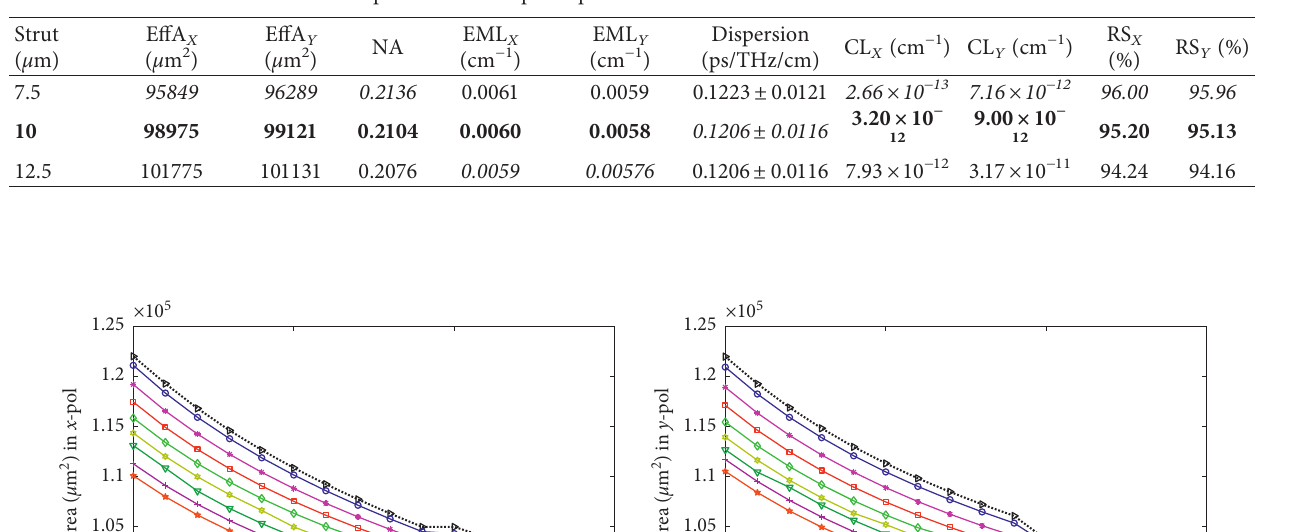
Table 3: Comparison of the optical parameters for the three strut values at 2.5 THz.